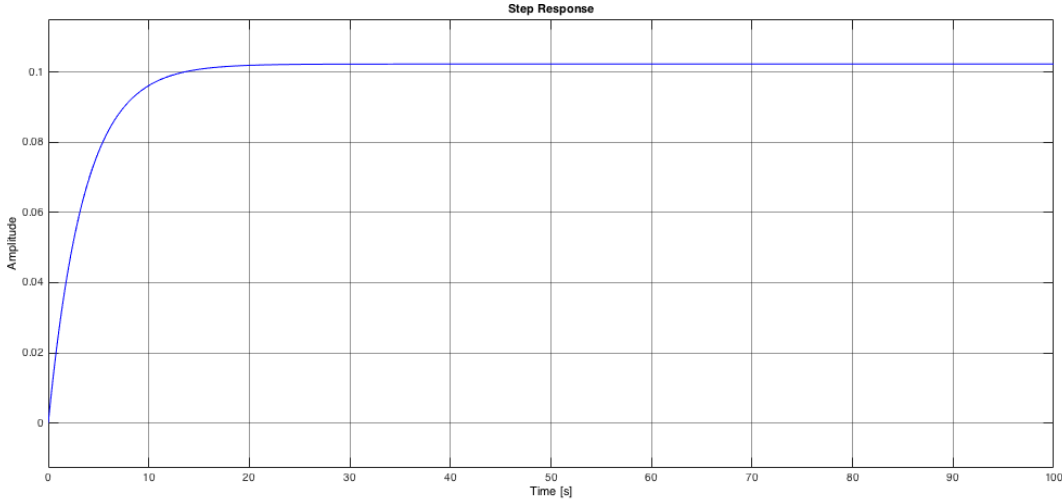
Figure 8. Step response system. In blue, the system behavior during 100 s.